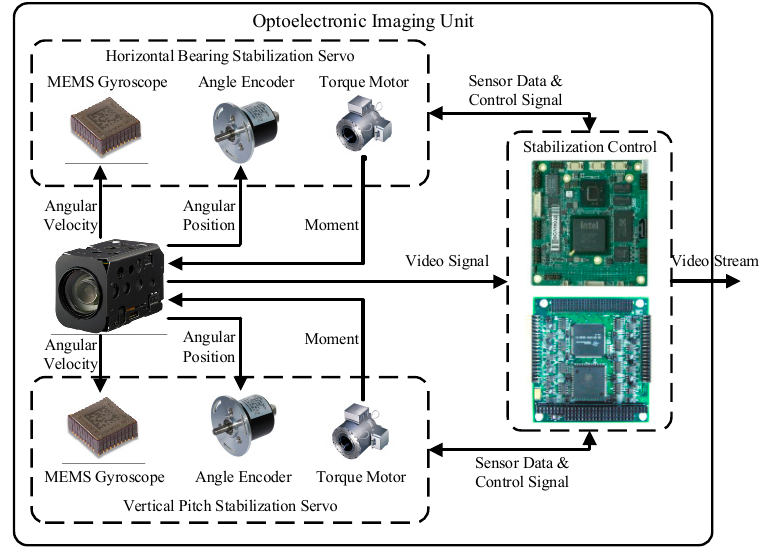
Figure 1. Hardware architecture of the optoelectronic imaging unit.